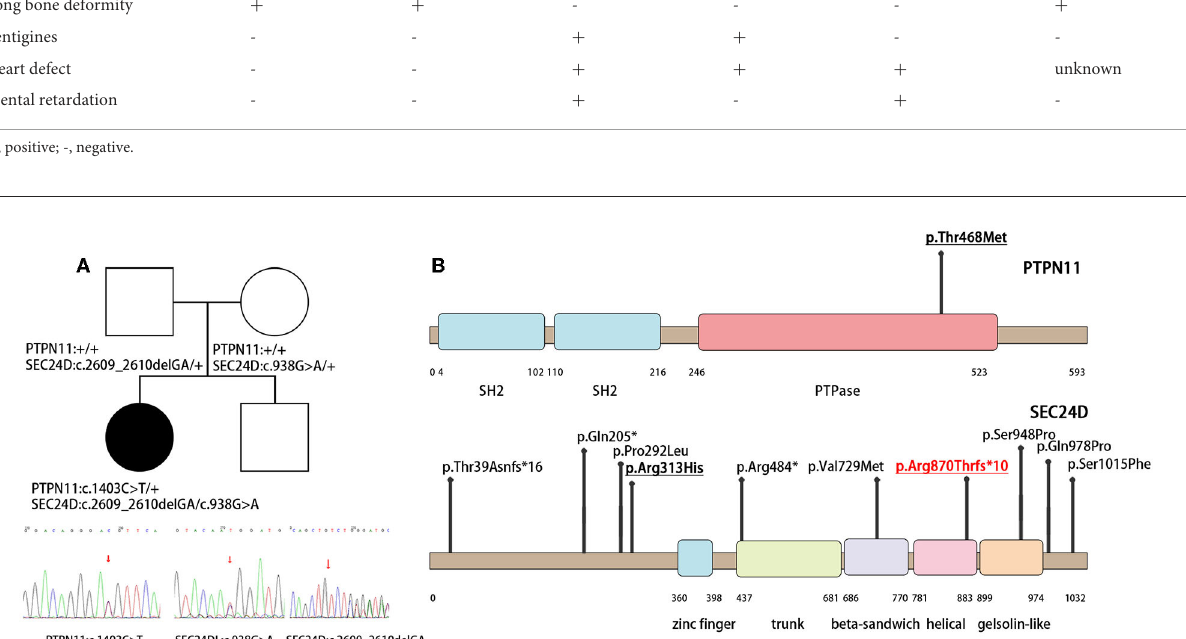
such as wormain bones, pelvis malformation and possible for repeated fractures (1, 2, 12). The dual gene mutation